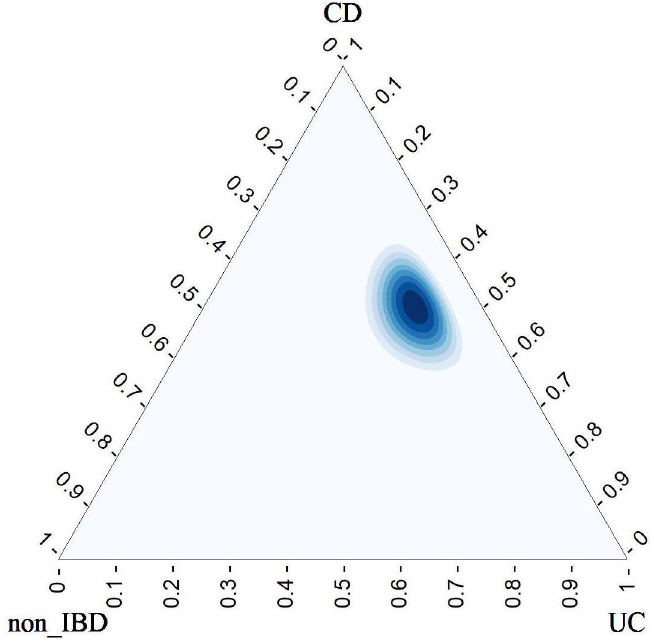
Figure 2. Posterior Dirichlet in A_UC .